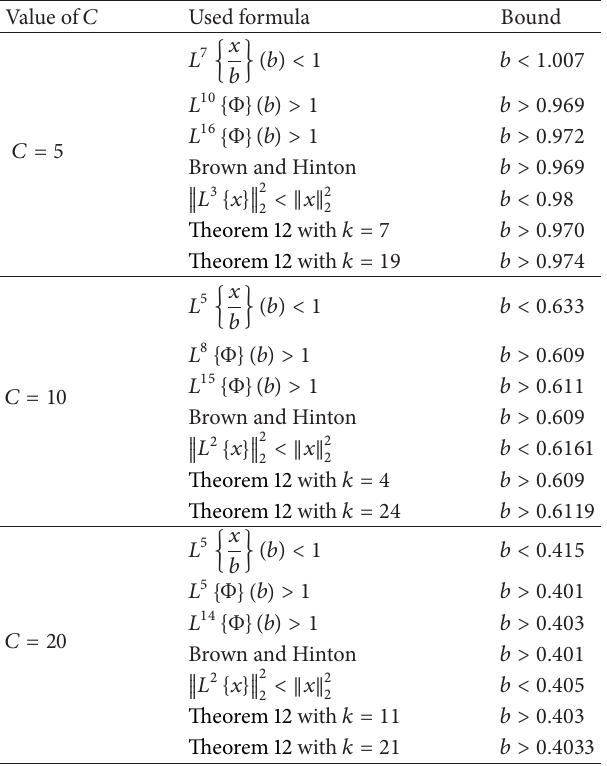
Table 3: Comparison of bounds for 𝑏 in Example 3.